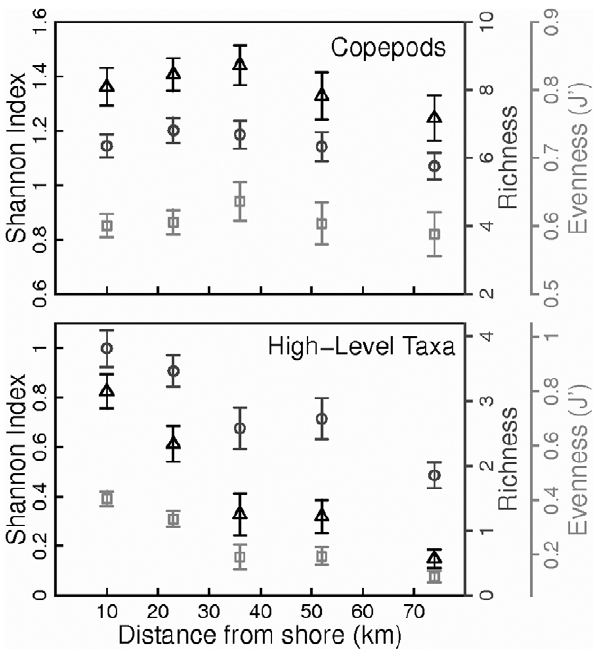
Figure 2. Cross-shelf variation in copepod and higher-level taxonomic diversity in the western Gulf of Maine. Triangles – Shannon index of diversity; circles - richness; squares - evenness. Data were collected and analyzed by the University of New Hampshire’s Coastal Ocean Observing and Analysis program and C. Manning. Richness is based on rarefaction to 50 individuals. Bars indicate standard error, and N=46, 45, 24, 25, and 19 for stations from nearshore to offshore, respectively. Higher level taxonomic groups were at classifi- cation levels ranging from class (e.g. Appendicularia and Polychaeta) to Phylum (e.g. Bryozoa and Cnidaria).